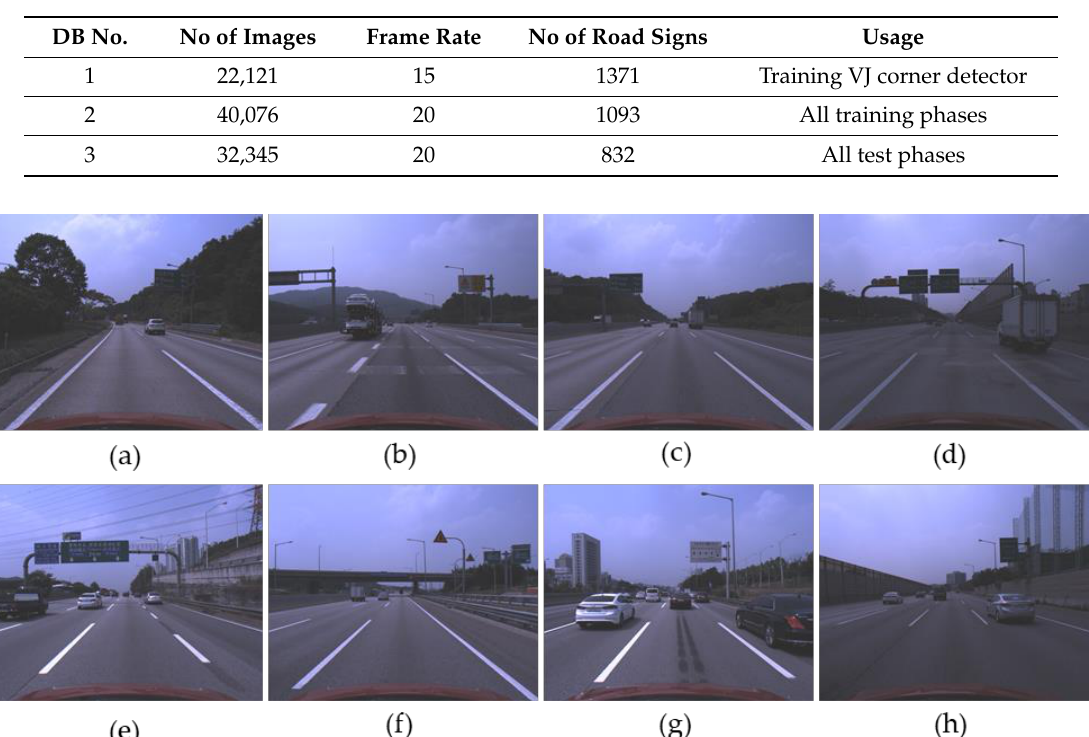
Figure 10. The effect of NMS considering the height of the road sign (( a ): considering only the road sign HV score, ( b ): considering the height as well).